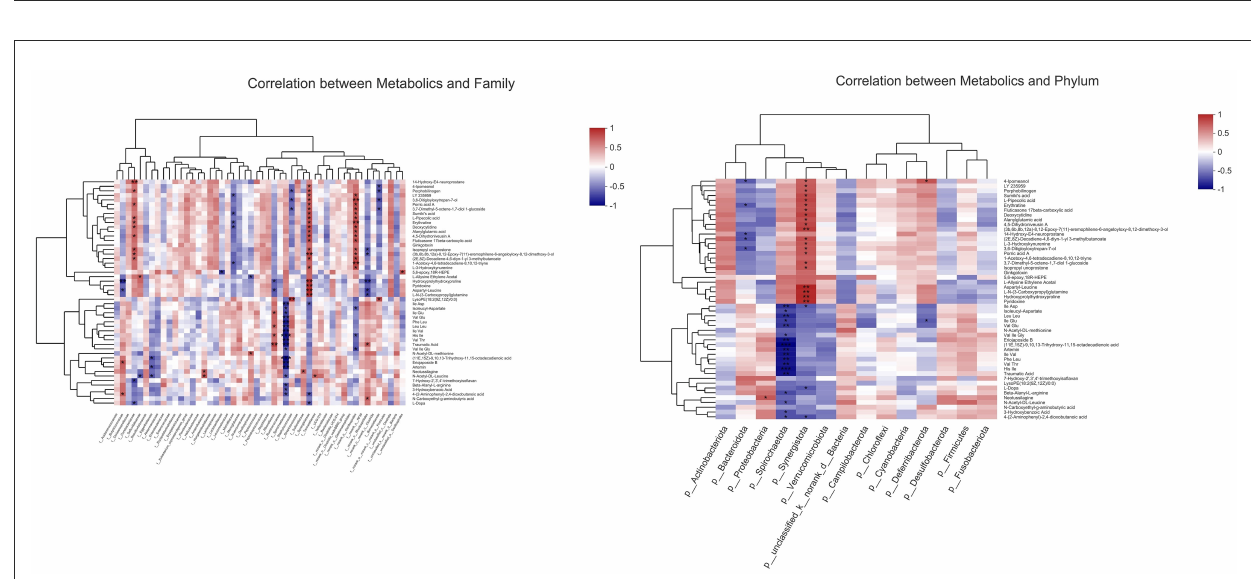
FIGURE11 Correlation analysis between metabolites and microorganisms at phylum and family level ( n = 6). * p < 0.05, ** p < 0.01, *** p < 0.001.